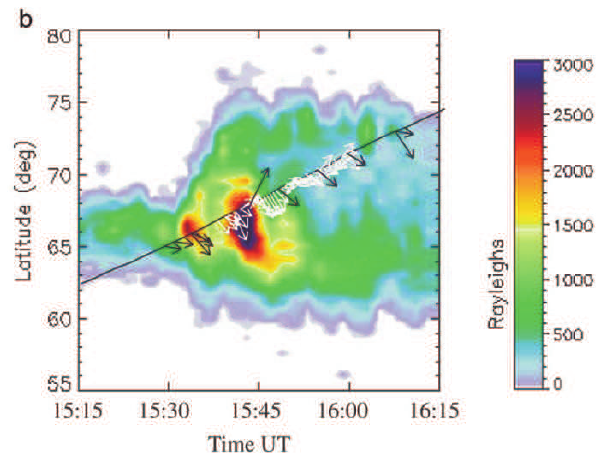
Fig. 25. A keogram showing the auroral emissions as a function of time in the midnight MLT sector from the FUV camera on IMAGE. The track of the Cluster 3 is given by the solid black line. The slopes of the black arrows give the horizontal velocities of the ion outflow structures and the slopes of the white arrows give the convection velocities determined from the EDI instrument on Cluster. (From Kistler et al.,